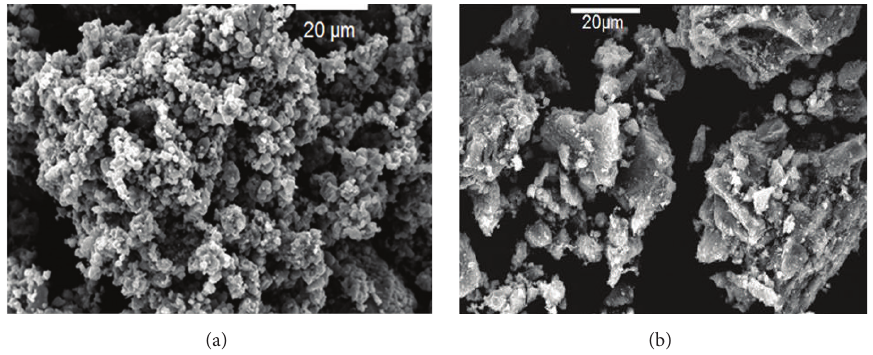
Figure 1: SEM images collected on anatase TiO 2 (a) and N-doped anatase TiO 2